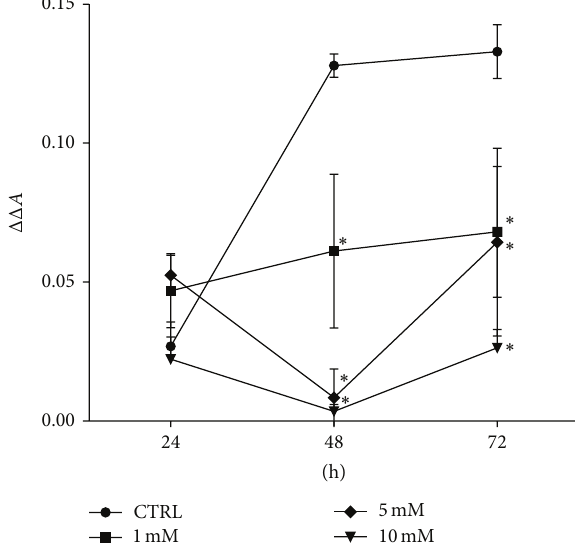
Figure 3: Proliferation activity of ASCs after metformin treatment at concentrations of 1mM, 5mM, and 10mM in comparison to the control culture (CTRL). The 𝑋 -axis refers to the time of cells’ propagation. The difference between absorbance read at 600 nm and 690nm, including absorbance of blank sample, was indicated as ΔΔ𝐴 mark ( 𝑌 -axis). The statistical significance ( 𝑃 < 0.01 ) was indicated with asterisk (∗) . Error bars represent standard deviation